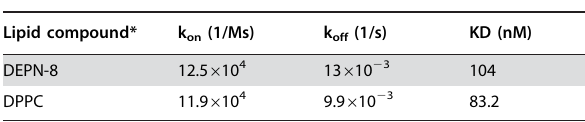
* Liposomes of DEPN-8 or DPPC in running buffer (10 mM HEPES, 150 mM NaCl, 3 mM EDTA, 0.005% Surfactant P20, pH 7.4) were flowed past a monolayer of Mini-B linked via Cys4 and Cys27 to a C5M sensor chip in a Biacore 3000 system (Methods). Mean kinetic rate constants (k on , k off ) and the equilibrium dissociation constant (KD=k off /k on ) were determined from curve fitting analyses of plasmon resonance results at six different lipid concentrations (0.1, 0.2, 0.3, 0.4, 0.5, and 0.6 m g/ml for each lipid). doi:10.1371/journal.pone.0001039.t002 .